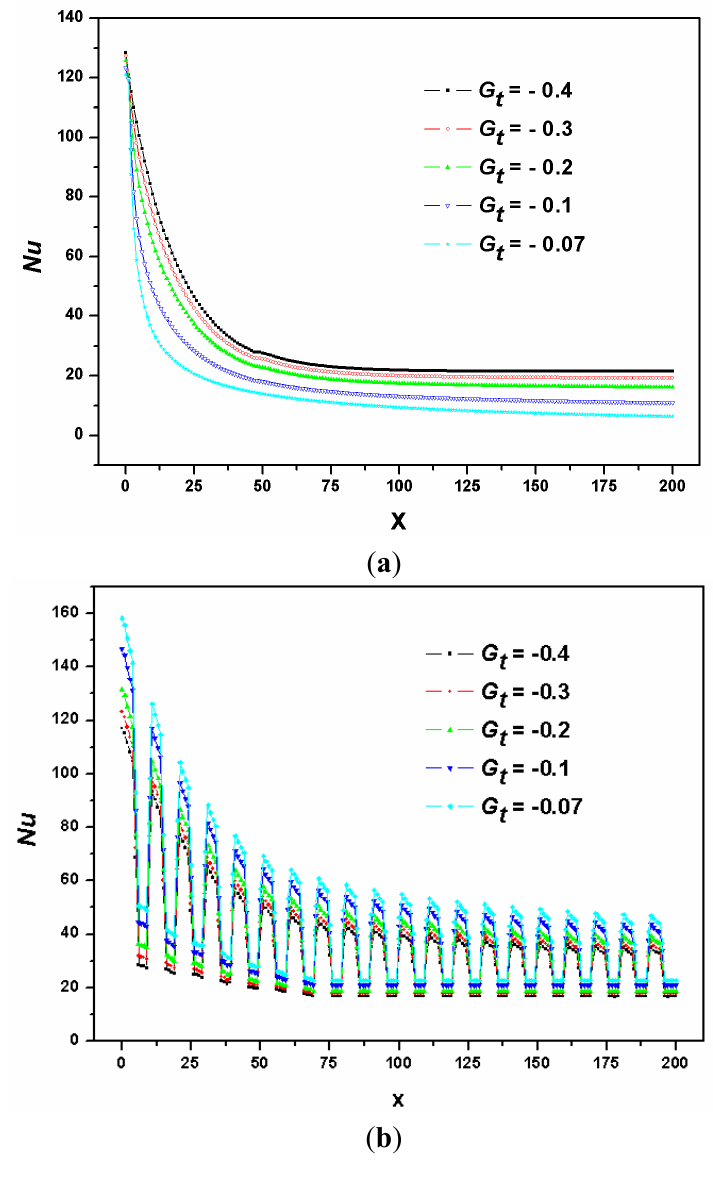
Figure 9. Local Nusselt number along the flowing direction for the channel flow with ( a ) smooth surfaces and ( b ) roughness surfaces ( 6.0  G